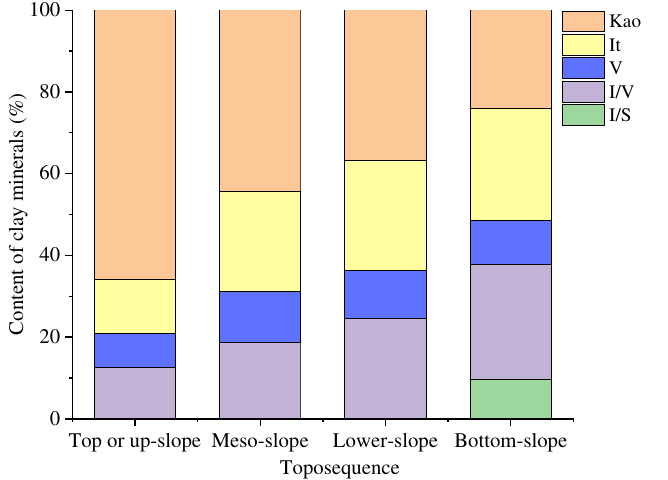
Figure 5. Relationships between relative contents of clay minerals and toposequence for the studied soils (Kao: kaolinite; It: illite; V: vermiculite; I/S: illite/smectite mixed-layer mineral; I/V: illite/vermiculite mixed-layer mineral).